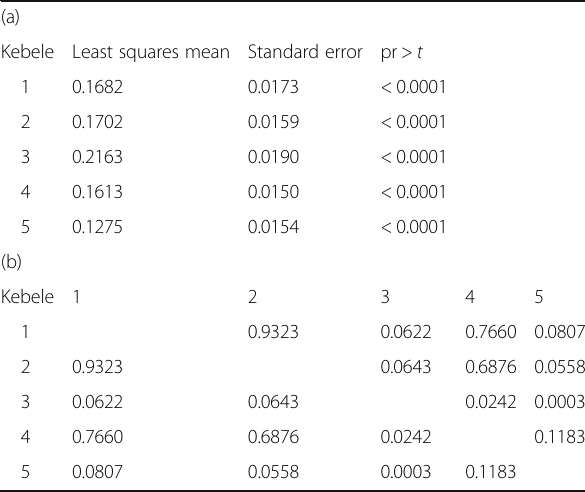
Table 6 Least squares means for effect kebele (part a) and least squares mean comparisons among kebeles (part